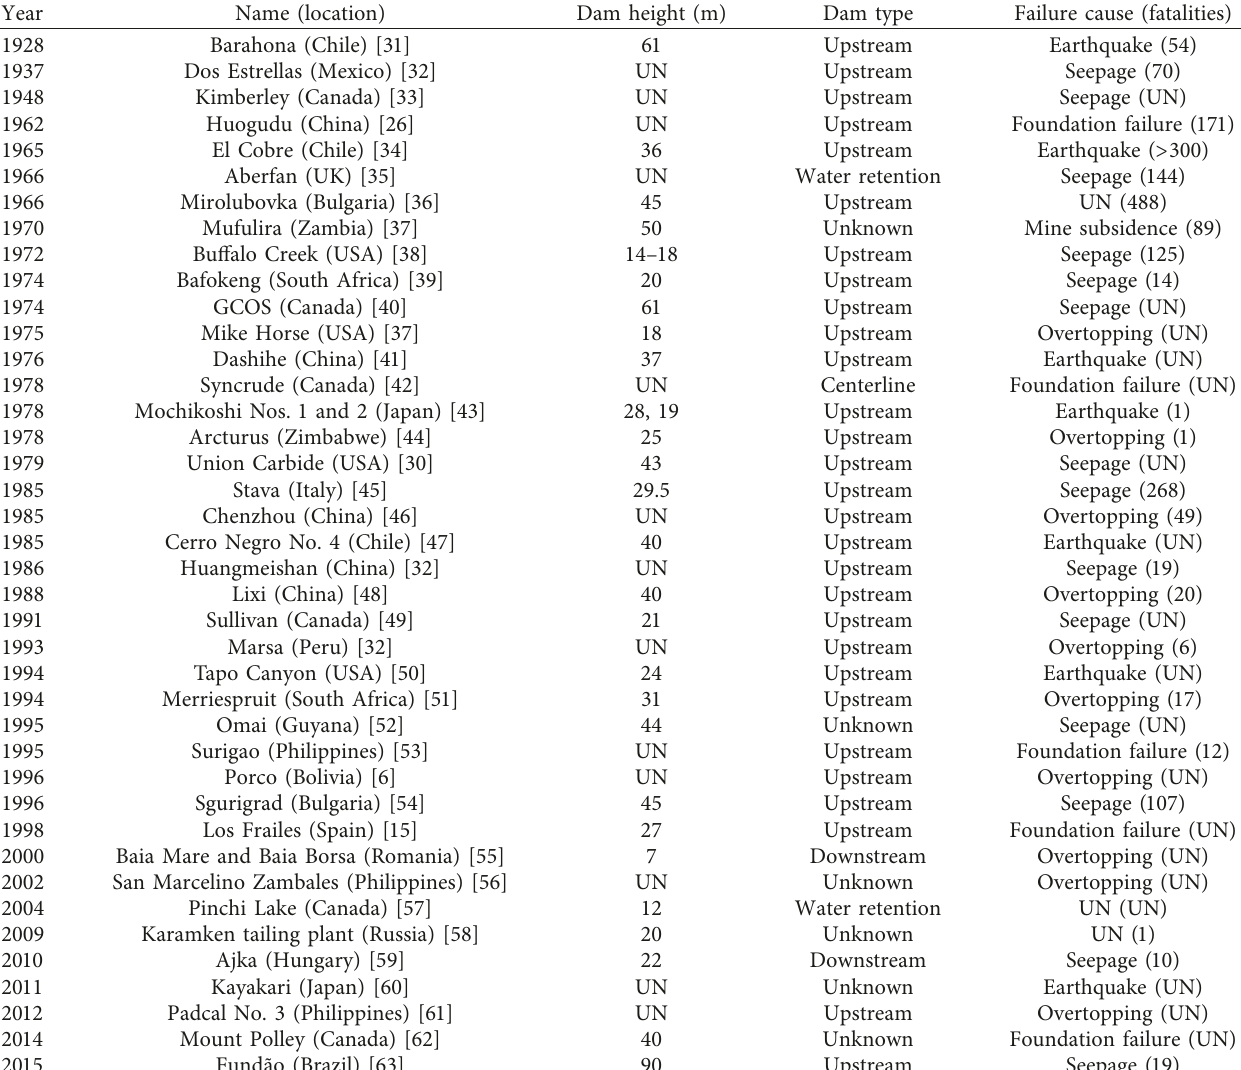
Table 1: Basic information regarding tailings impoundment